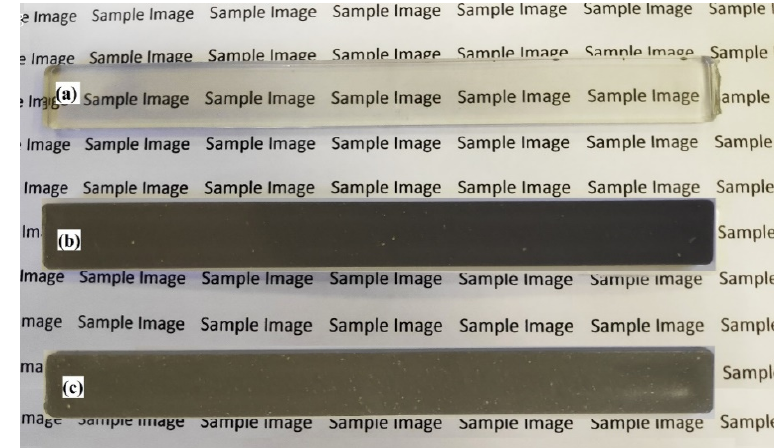
Figure 3. Appearance of the ( a ) Amorphous PET, ( b ) Al-PET composite with nano Al 2 and ( c ) Al-PET composite with micro Al 1. Note that the bar with micro Al shows speckle due to large specks of shiny Al particles.